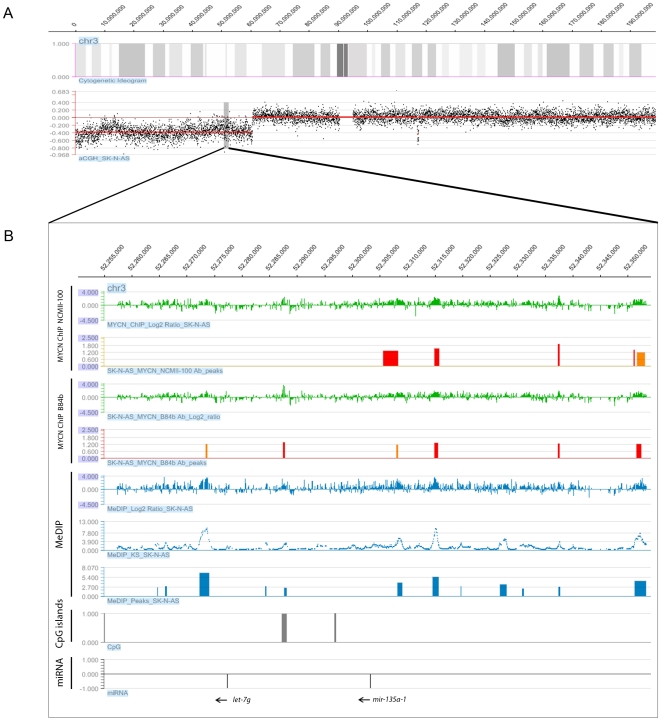
Association of MYCN binding and DNA hypermethylation around the let 7g and miR-135a-1 locus in SK-N-AS NB cell line.(A) Array-CGH profile of chromosome 3p displaying a large 60.5 Mb terminal deletion in SK-N-AS. (B) Detailed view of the hemizygously deleted let-7 g/miR135a-1 locus. The upper two panels display the MYCN ChIP-chip raw log2 ratios and identified peaks for both MYCN antibodies (NCMII-100 and B84b). Red and orange peaks represent regions of enrichment with an FDR of <0.05 and 0.05–0.1, respectively. MeDIP results for SK-N-AS are displayed in the lower panels in blue, which include log2 ratios of MeDIP/Input, Kolmogorov-Smirnov test p-values (−log10) and the merged statistically significant peaks of hypermethylation across the region. The position of CpG islands and orientation of miRNAs are displayed in the two bottom panels.